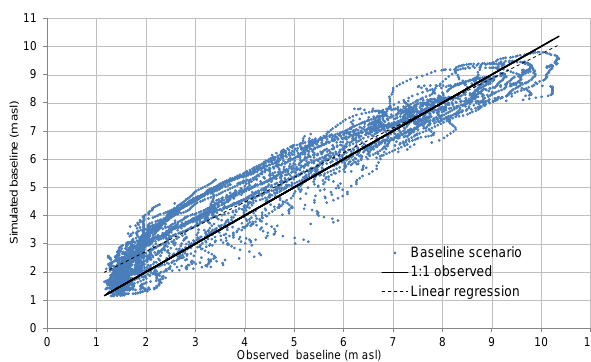
Figure 3. Observed versus projected daily water levels (in meters above sea level, ma.s.l.) during 1986–2000 at Kampong